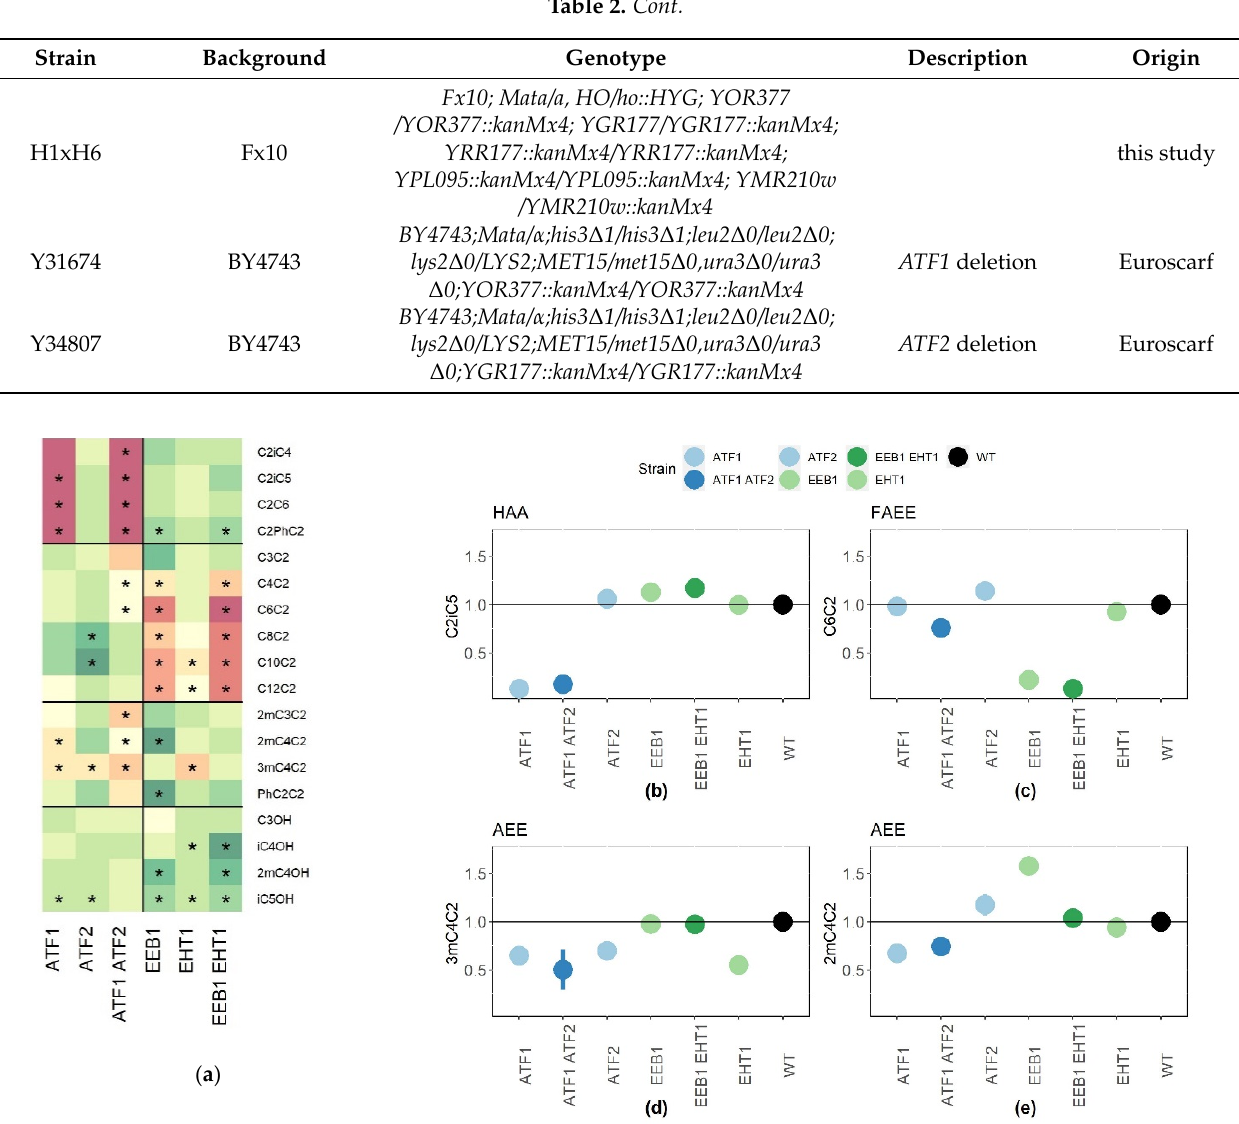
Figure 1. Depletion effect of the activities of acetyl-transferase (Atf1p/Atf2p) and acyl-CoA:ethanol-O-acyl transferase (Eeb1p/Eht1p) on linear esters. ( a ) Modalities significantly different from the wt are shown for all the volatile compounds measured. The symbol * indicates which modality is significantly different from the wt according to a Kruskal–Wallis test followed by a post-hoc Fisher’s LSD analysis ( α = 0.01). ( b – e ) Gene deletion effects for representative compounds of each ester class family, C2iC5 (isoamyl acetate), C6C2 (ethyl hexanoate), 3mC4C2 (ethyl 3methyl butanoate), and 2mC4C2 (ethyl 2methyl butanoate), respectively. The raw values of each deletion strain were normalized by the average value of the control strain Fx10. Each point and bar represents the mean and the standard error computed from 3 to 6 independent biological